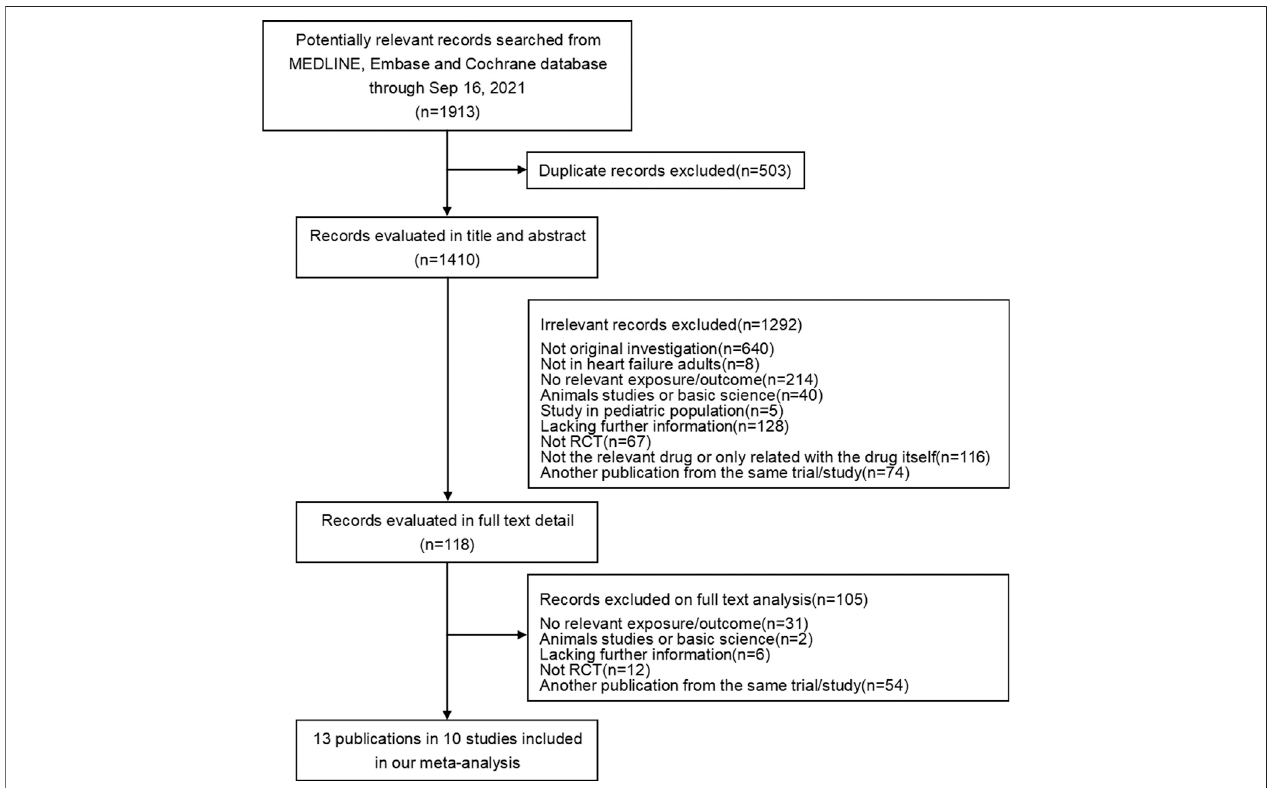
FIGURE 1 | Screening fl ow